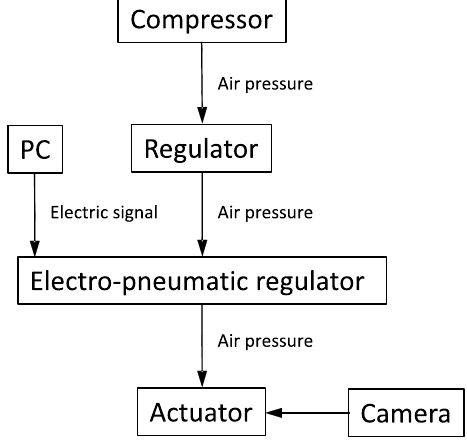
Figure 10. Flowchart of the experimental